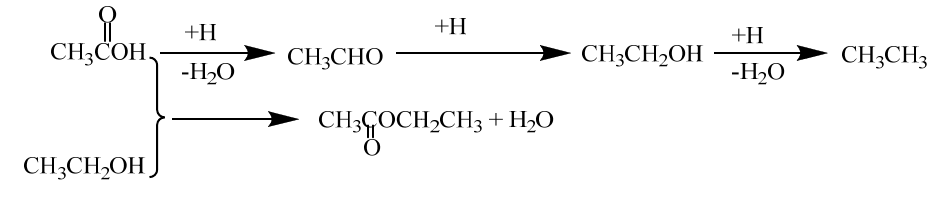
Figure 4. Effect of temperature on conversion of acetic acid. Reaction conditions: P = 3 MPa, WHSV = 1.5 h − 1 , H 2 /feedstock =